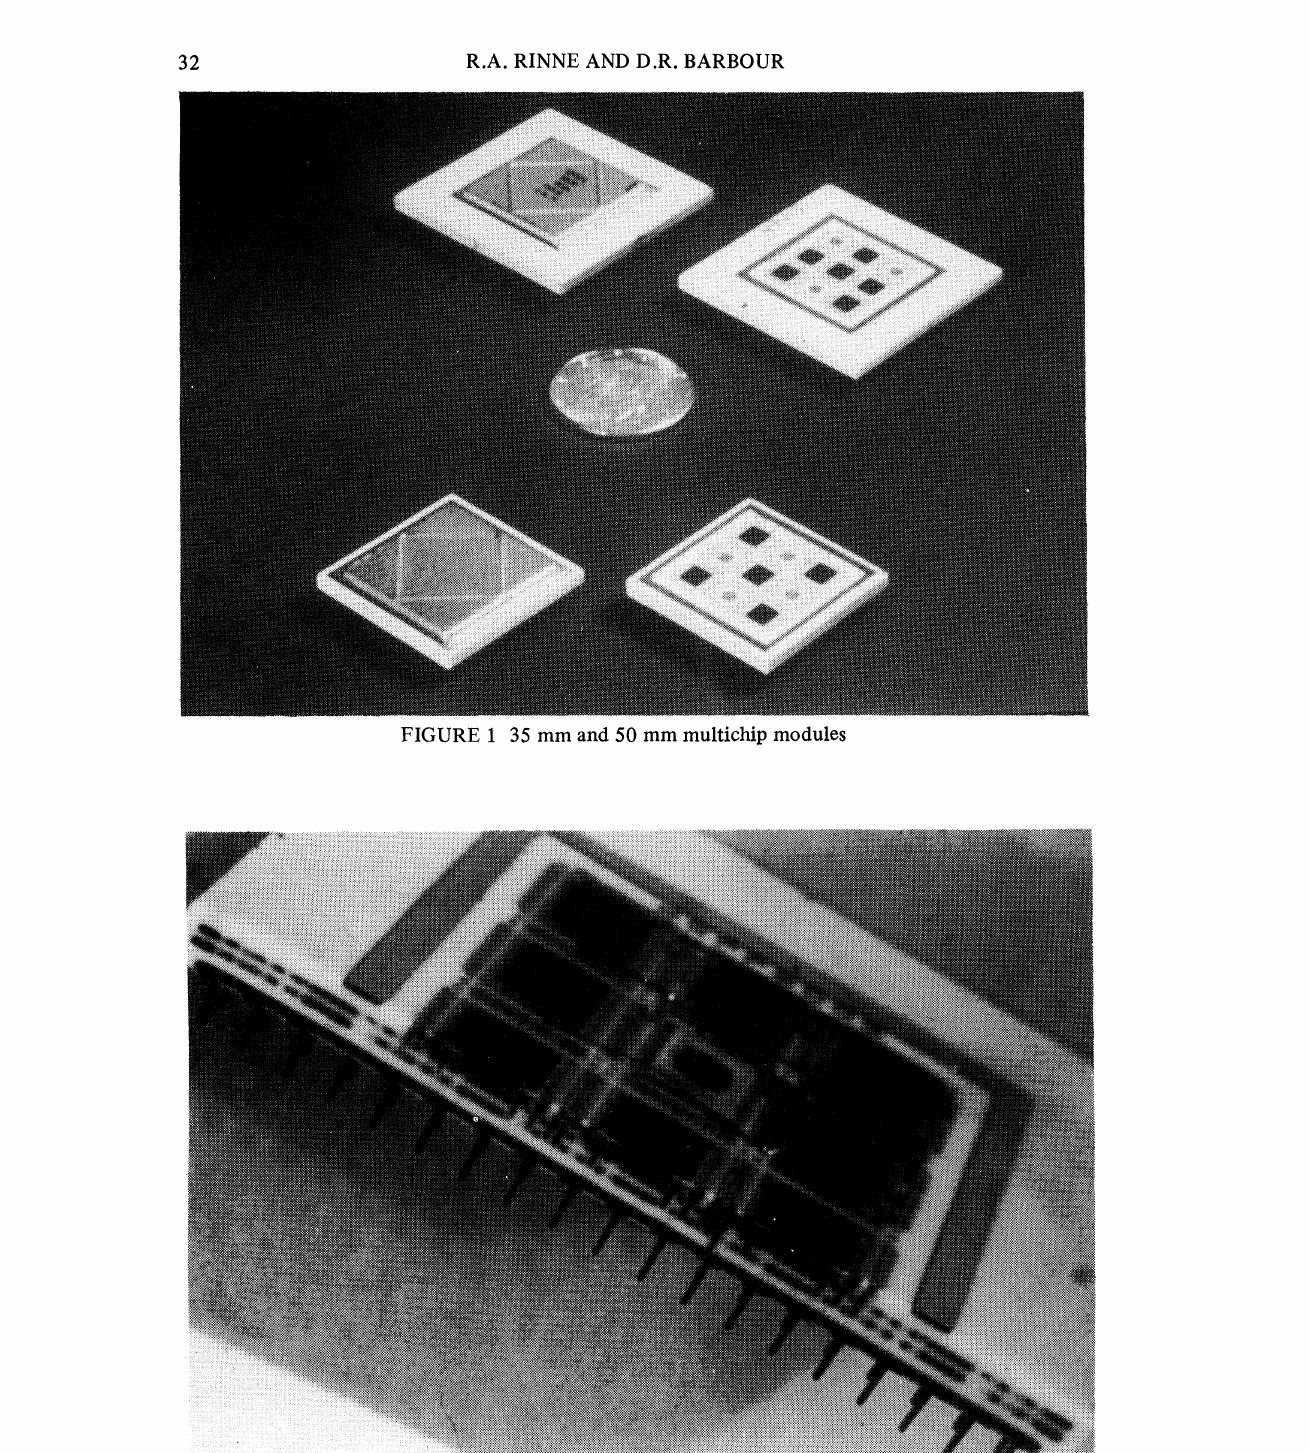
FIGURE 2 50 mm substrate cross